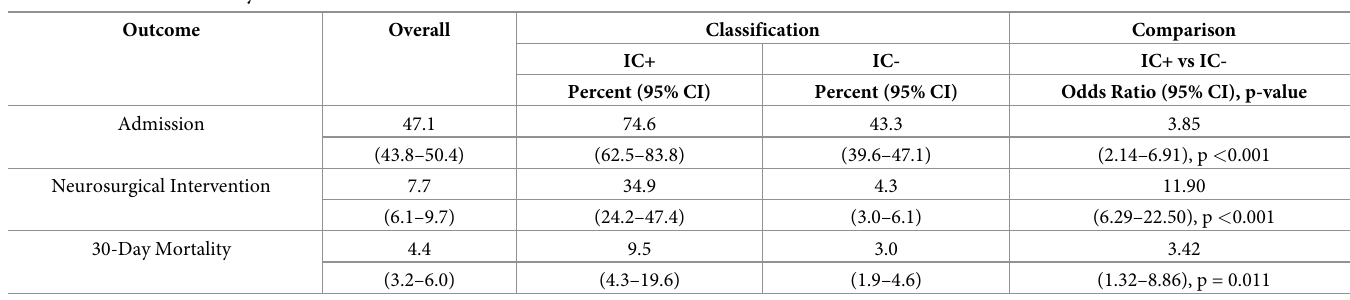
Table 2. Clinical outcomes by classification.